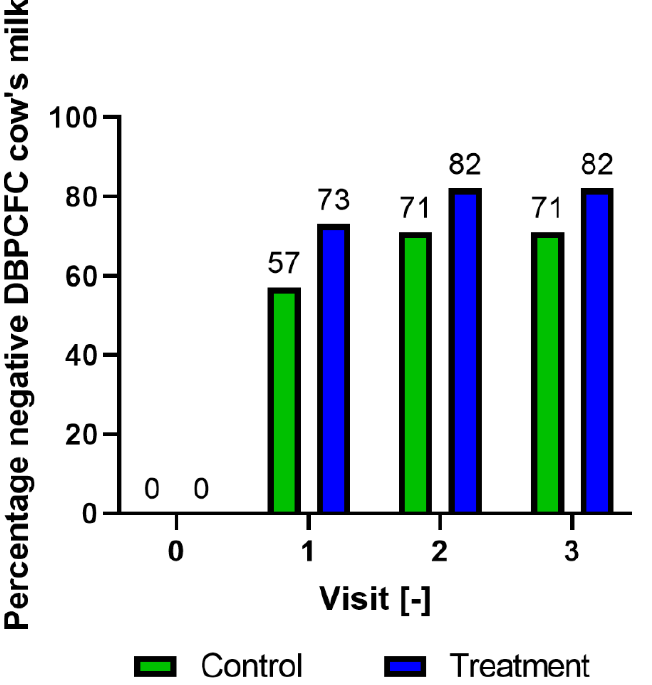
Figure 2. Results of the DBPCFC with cow’s milk; DBPCFC: double-blind placebo-controlled food challenge.